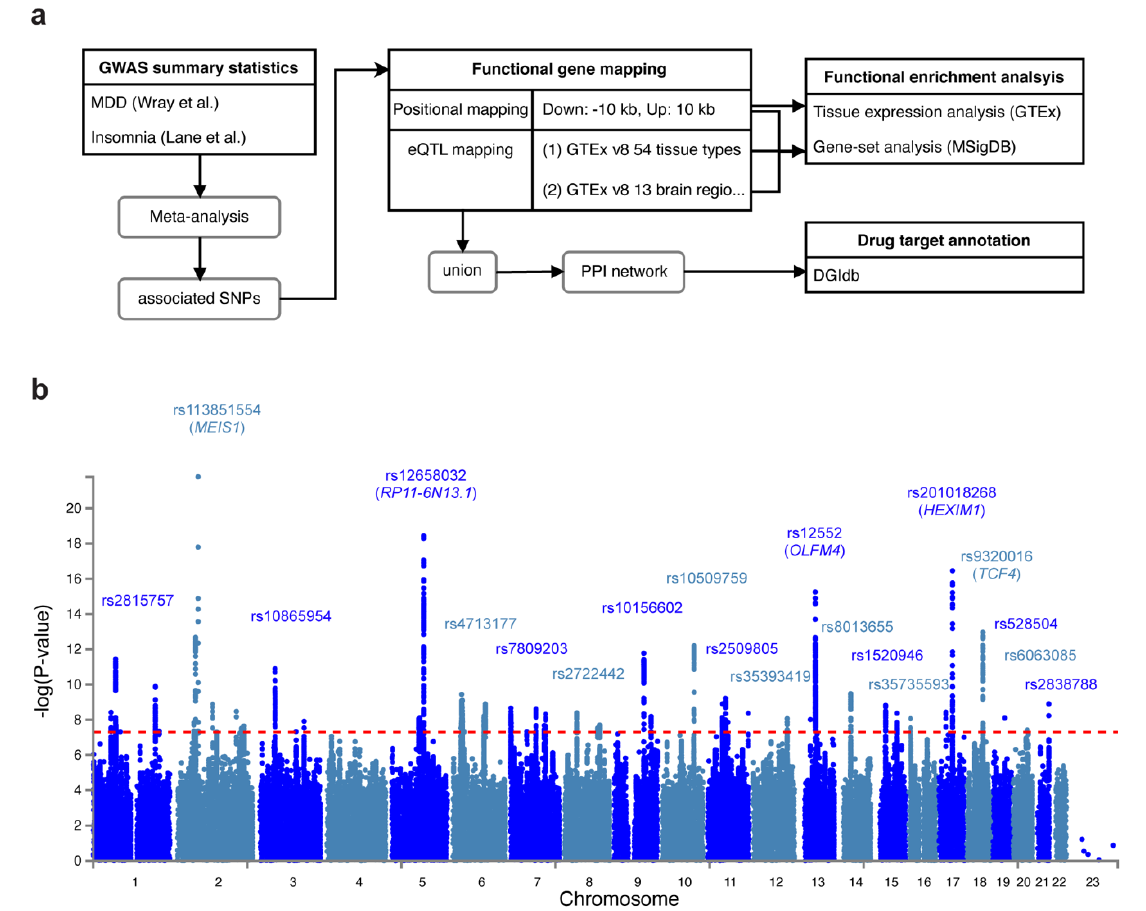
Figure 1. Study flow chart and Manhattan plot for the meta-analysis of MDD and insomnia. ( a ) Flow chart that depicts the workflow of our study. ( b ) Manhattan plot that shows the associated SNPs. The red dashed line indicates the genome-wide significance threshold at p = 5 × 10 −8 .